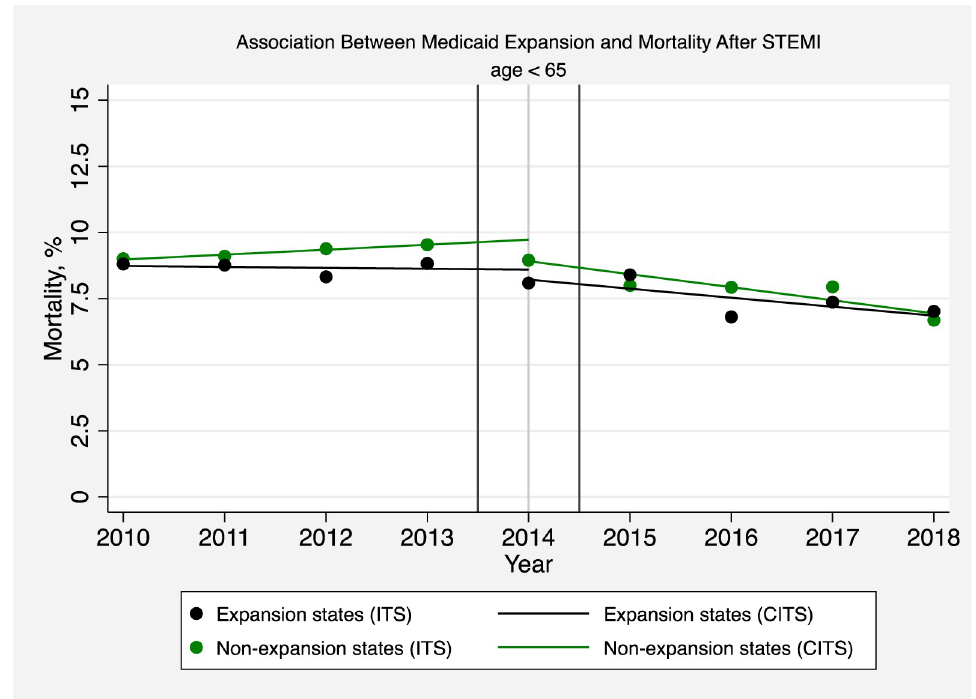
Fig 5. Association between medicaid expansion and mortality after STEMI (age < 65). The solid circles represent the yearly estimates for the mortality rate in patients hospitalized with a STEMI based on an interrupted time series (ITS) model after adjusting patient-level and hospital effects, without imposing restrictions on time trends and making no assumptions that time effects were different before or after 2014. The solid lines are based instead on a comparative interrupted time-series (CITS) model but assume that pre-intervention and post-intervention trends are linear in order to interpret changes in mortality rates before and after Medicaid expansion.